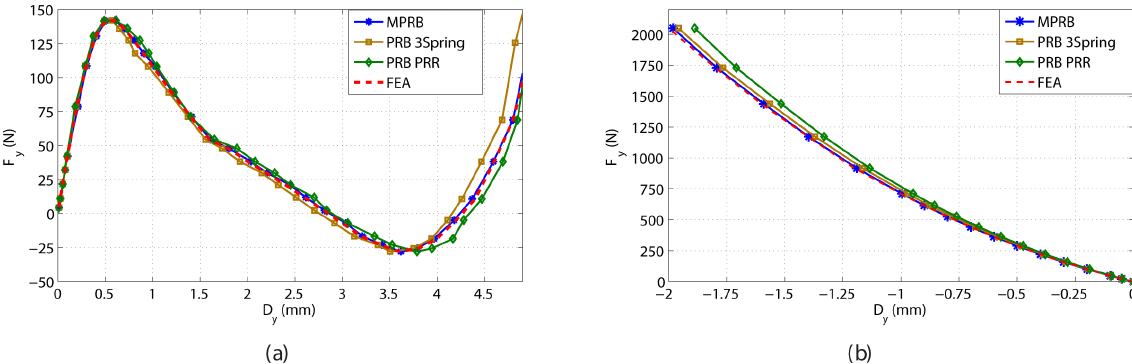
Figure 12. The force-deflection curves of the bistable mechanism. (a) Positive displacement. (b) Negative displacement.